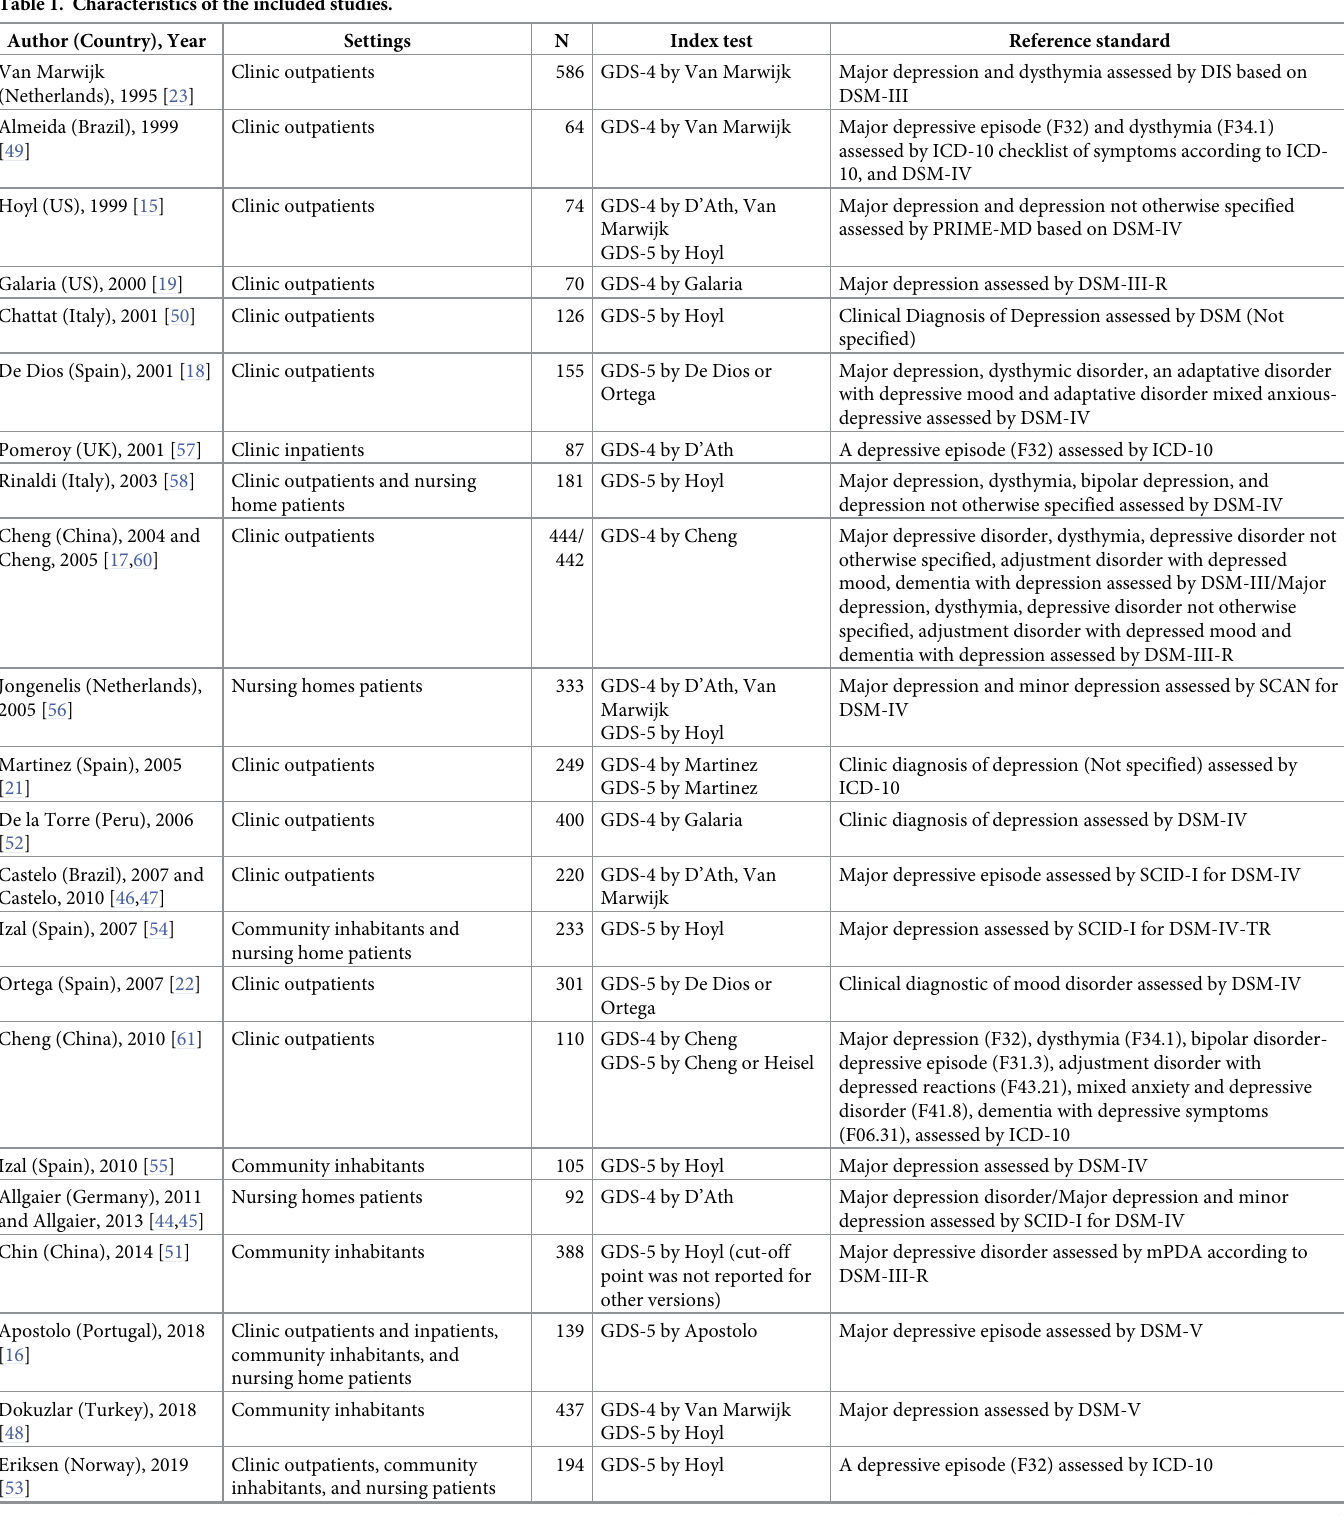
Table 1. Characteristics of the included